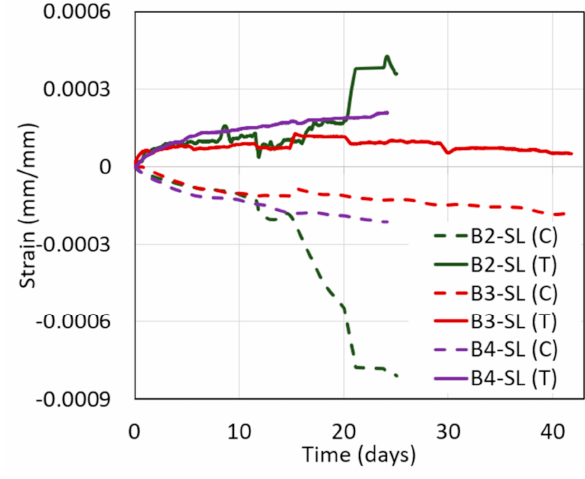
Figure 20. Strain increase with time during sustained loading for series I.